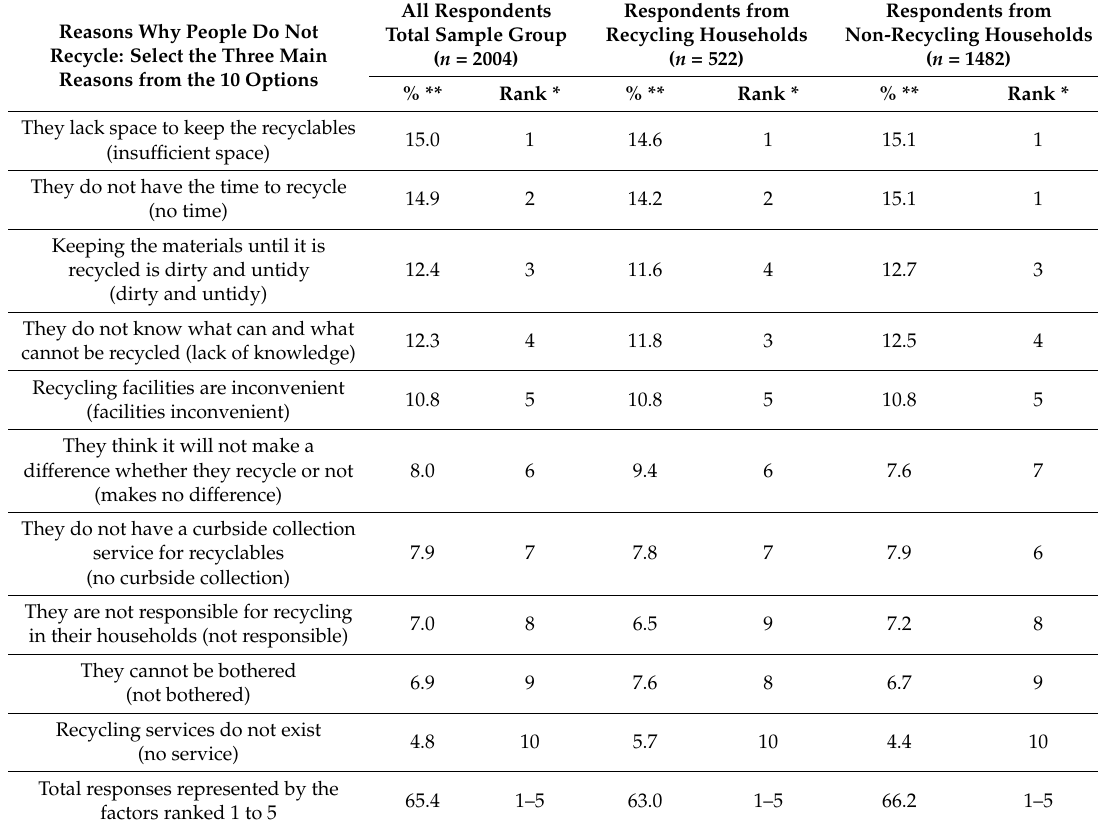
Table 4. Perceptions why people do not recycle—order of priority (rank) of the three main